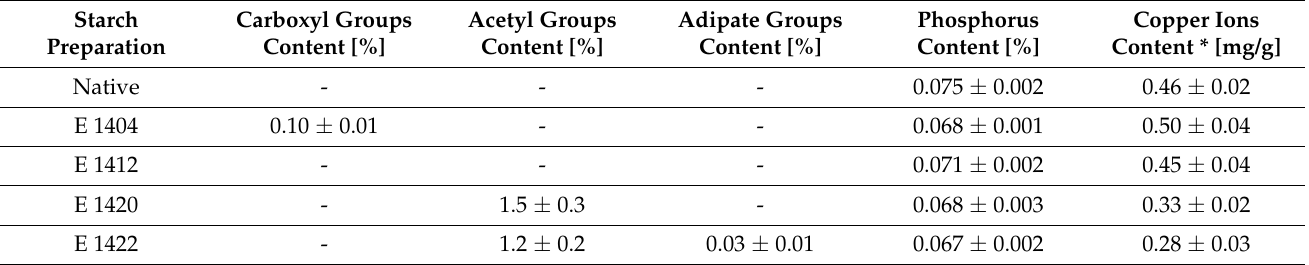
Table 1. Basic chemical characteristics of the adsorption process and the starches